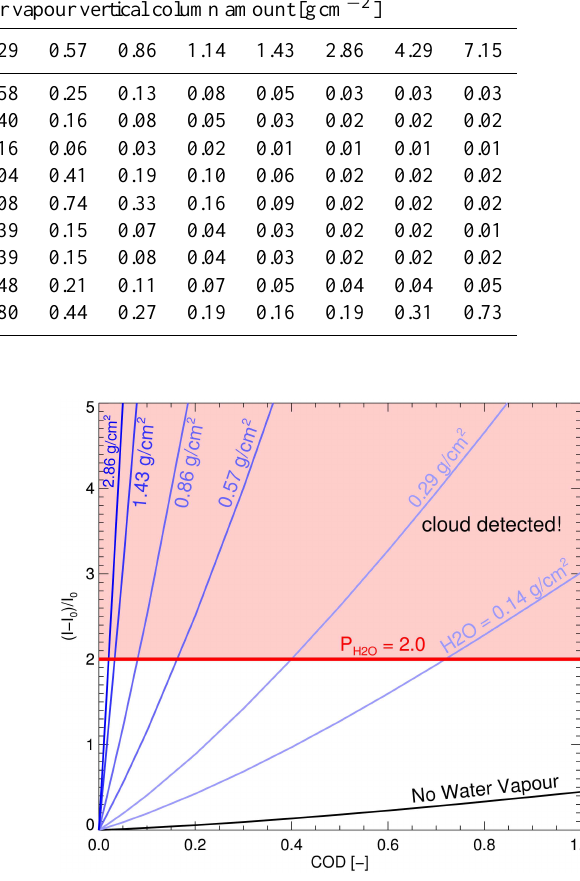
Fig. 4. The cloud detection threshold (red horizontal line) based on strong water vapour absorption lines covering the spectral region 1395–1410nm compared to results obtained from radiative trans- fer simulations. Deviations of simulated intensities ( I ) for various cloud scenarios to the reference intensities ( I 0 ) simulated without cloud are shown as a function of cloud optical depth (COD) and different water vapour column amounts (H 2 O [gcm − 2 ]) . The sim- ulations are valid for a solar zenith angle of 40 ◦ , a surface albedo of 0.1, the default aerosol scenario, a cloud top height of 10km and a cloud geometrical thickness of 0.5km. The red line indicates the = 2 . 0. cloud detection threshold P H 2 O